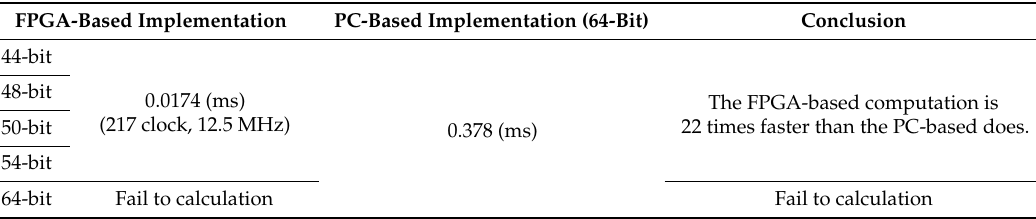
Table 4. Comparision of FPGA-based and PC-based computing time.